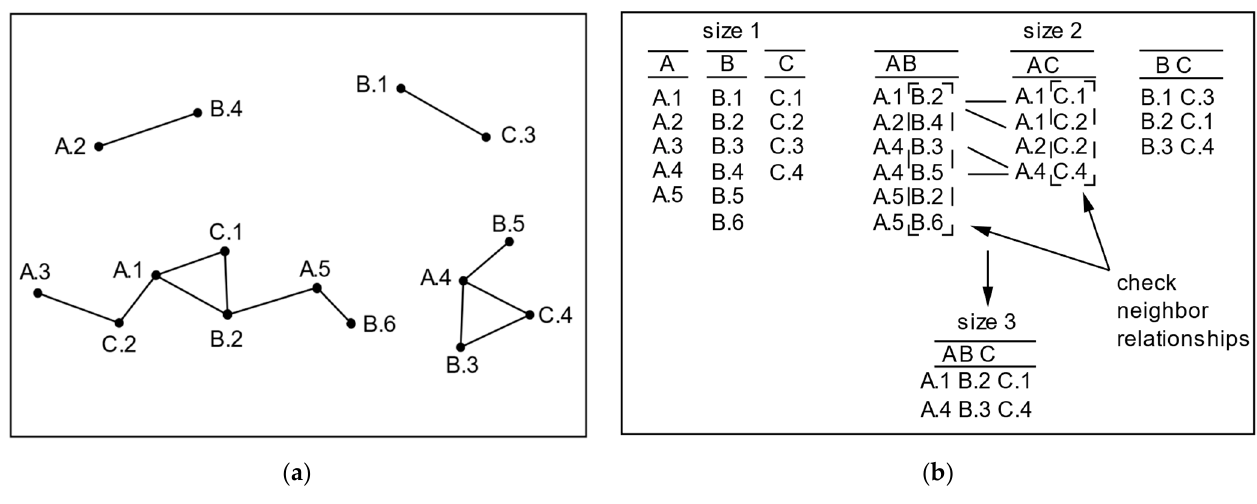
Figure 1. ( a ) An example data set; ( b ) instance joins.